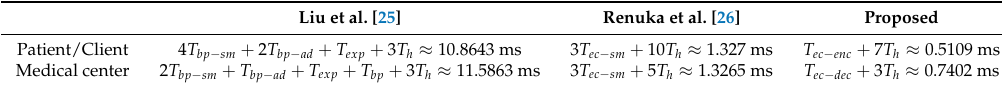
Table 3. Computation costs of the proposed scheme with related